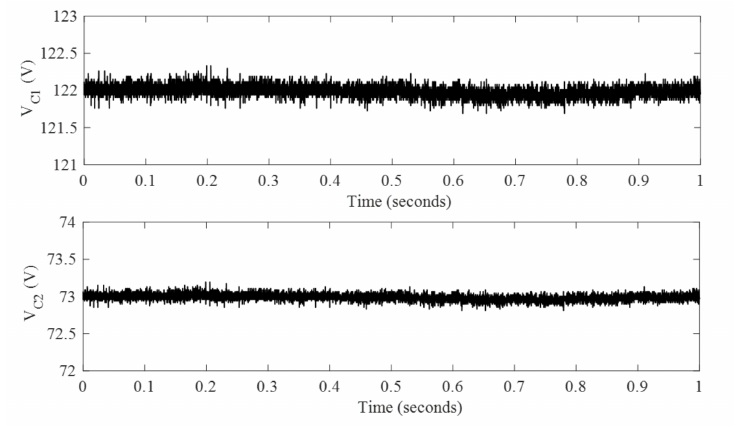
Figure 16. Proposed SL-SBZSI: capacitor voltage, V C 1 and V C 2